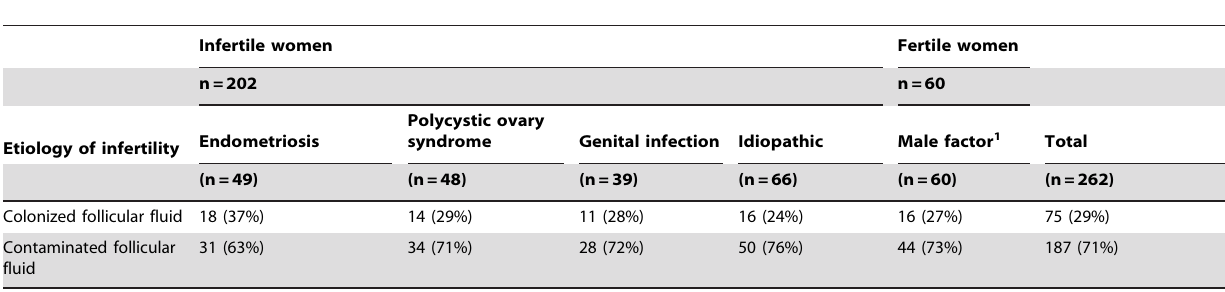
Table 1. Number of women with colonized or contaminated follicular fluid and the causes of infertility.